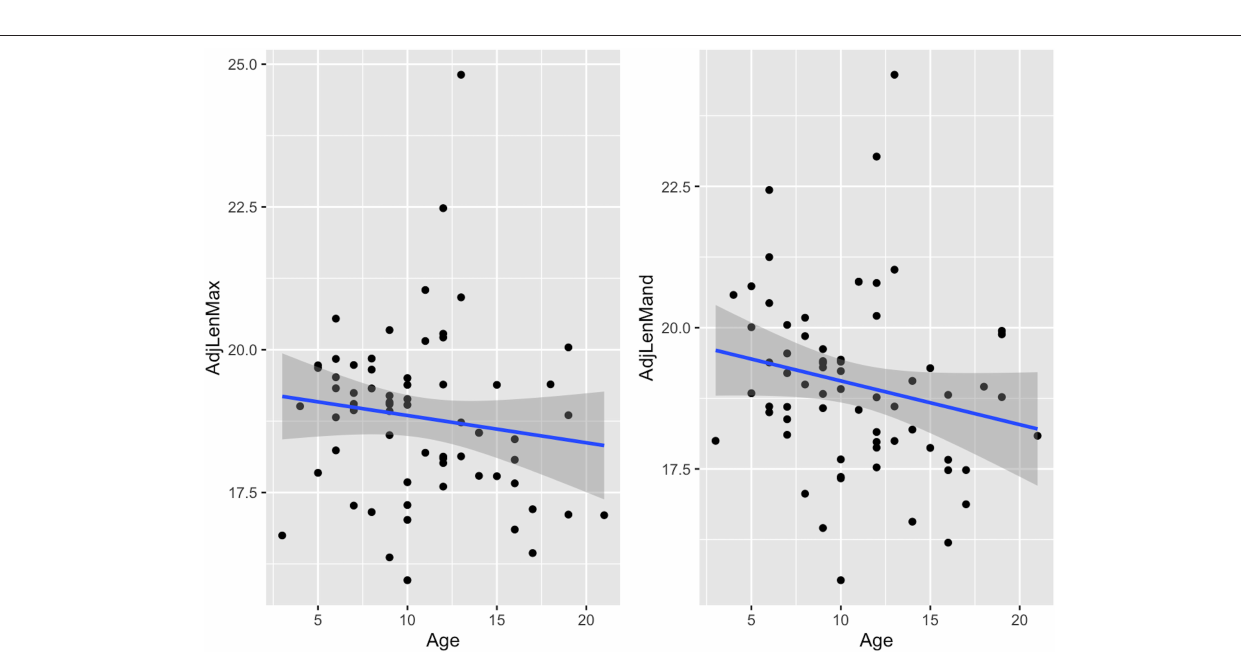
FIGURE 9 | Scatterplots with linear regression lines (blue) and confidence intervals (dark gray shading) plotted, showing associations between age (years) and adjusted cheek teeth arcade lengths (cm) in 67 horses. AdjLenMax, adjusted mean maxillary cheek teeth arcade length; AdjLenMand, adjusted mean mandibular cheek teeth arcade